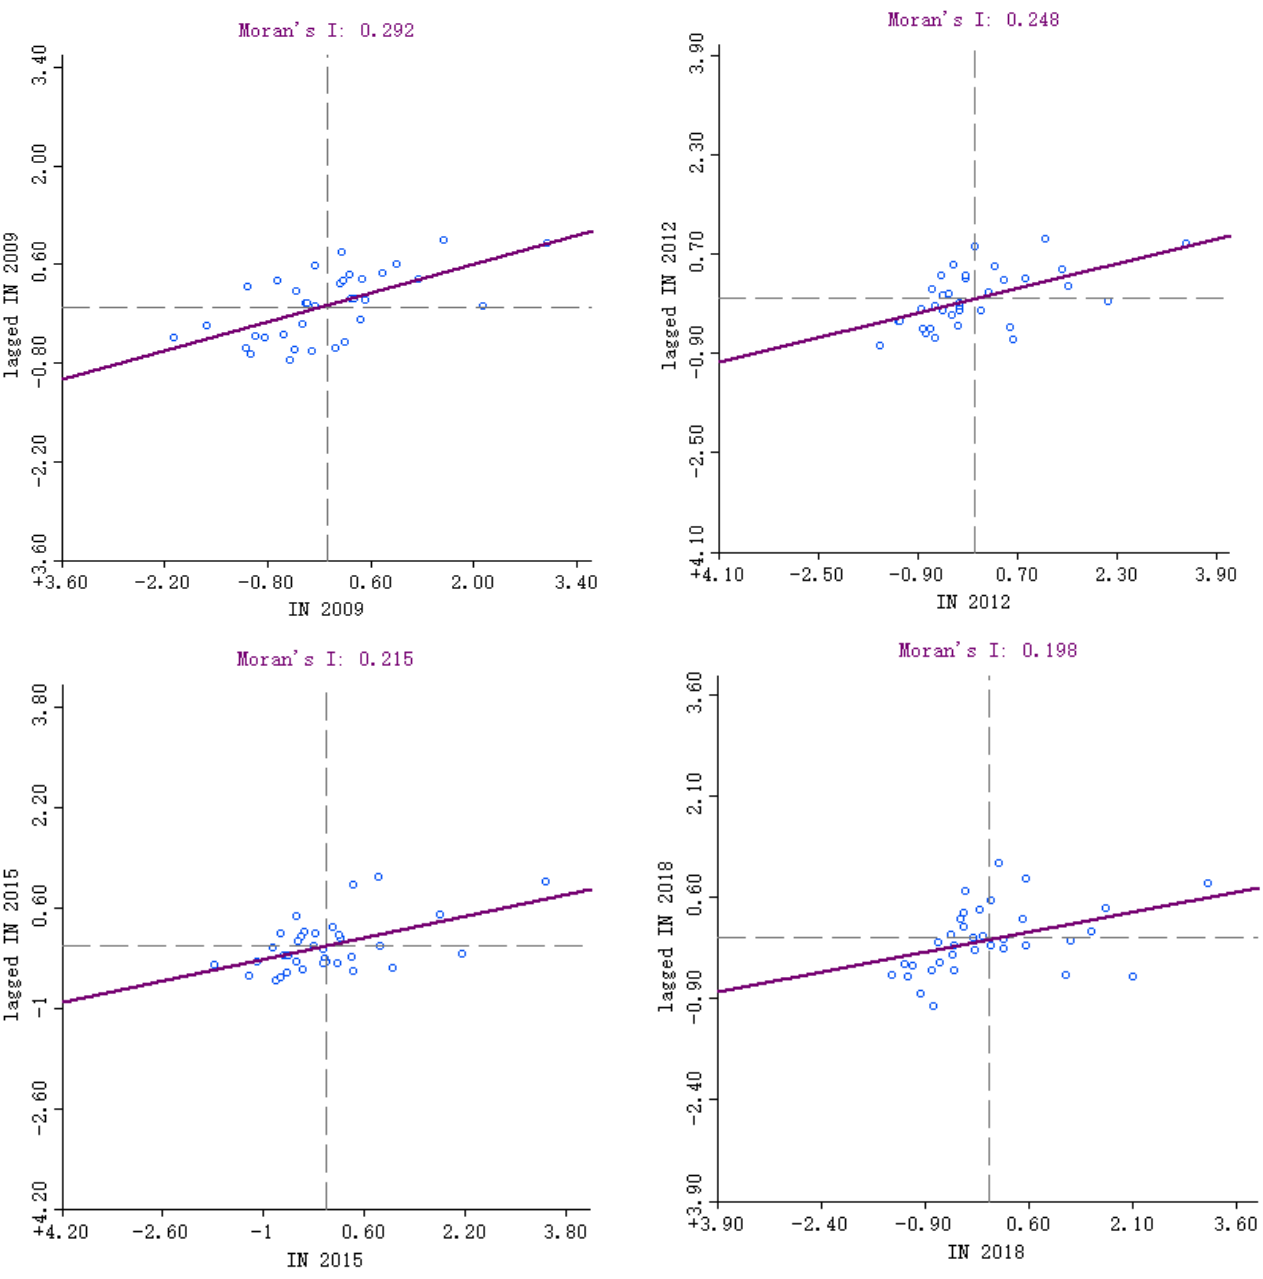
Figure 7. Moran scatter diagram of local autocorrelation of the tourism urbanization indexes of major tourist cities in China.